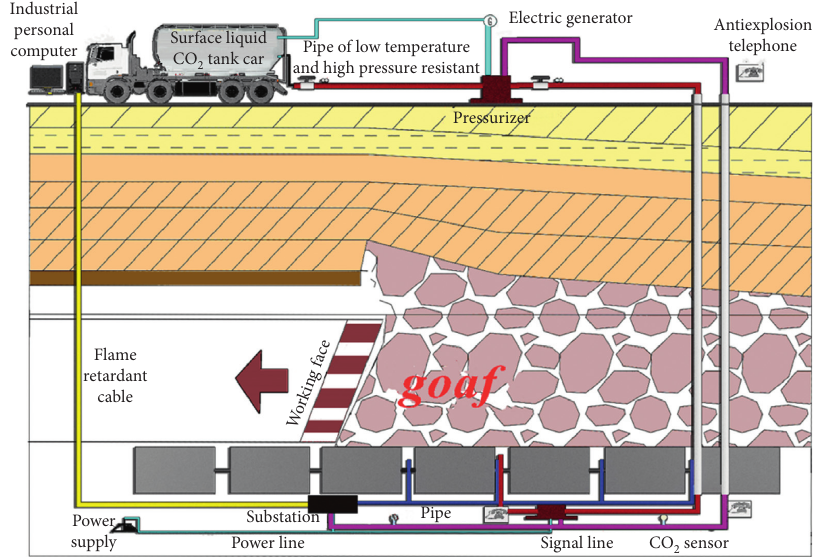
Figure 17: Process scheme of ground liquid CO